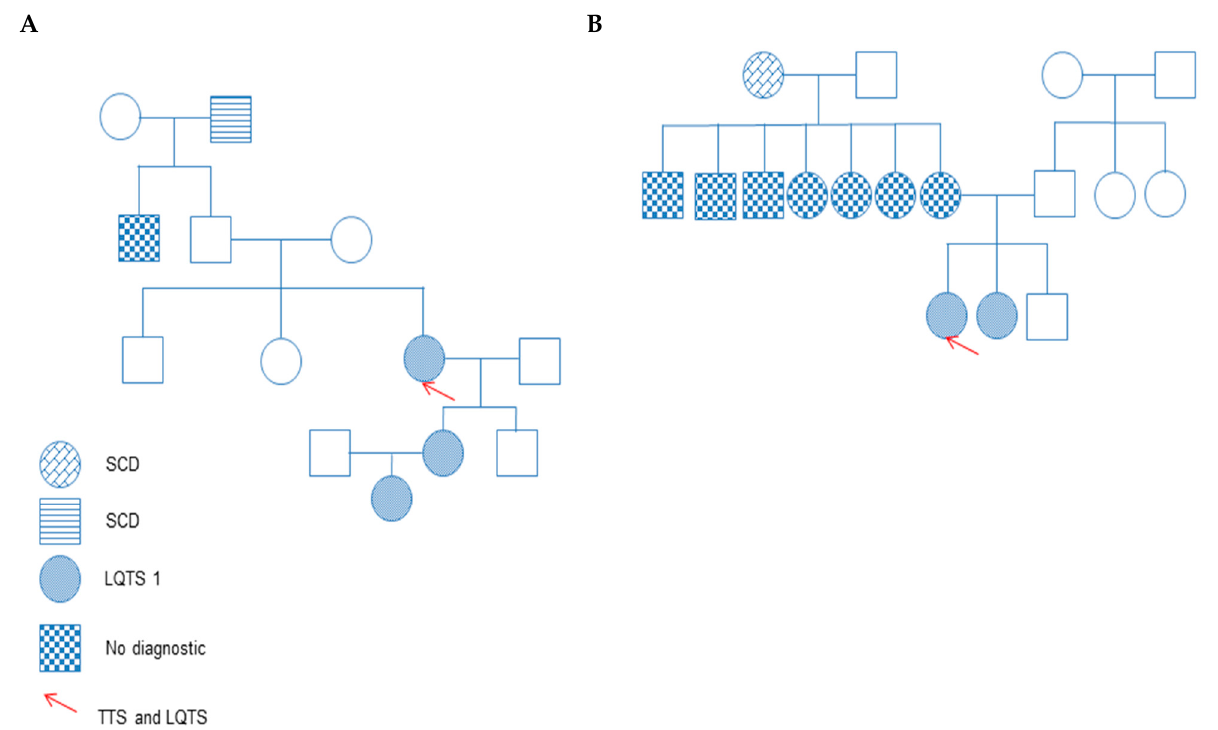
Figure 2. ( A , B ) Family pedigrees of two TTS patients affected by LQTS 1 at random after a de- tailed screening due persistence of ECG changes despite recovery of TTS.